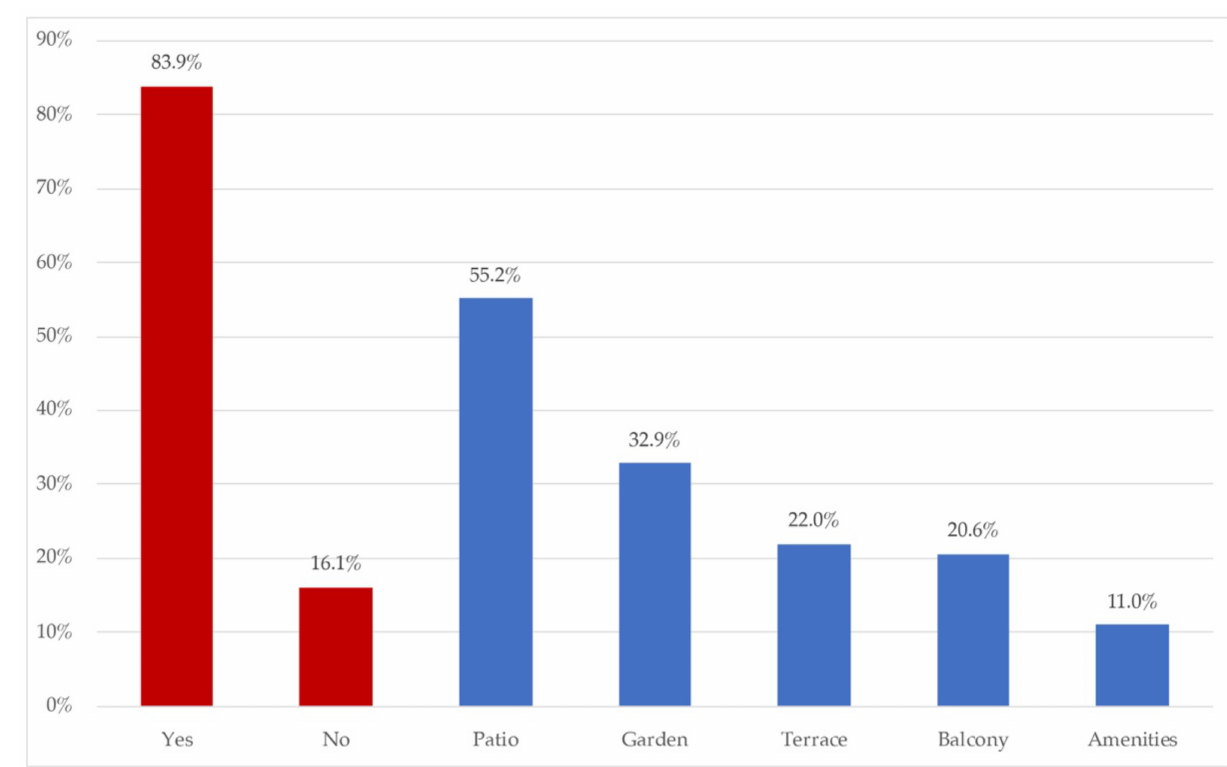
Figure 4. Availability and type of open spaces offered by participating